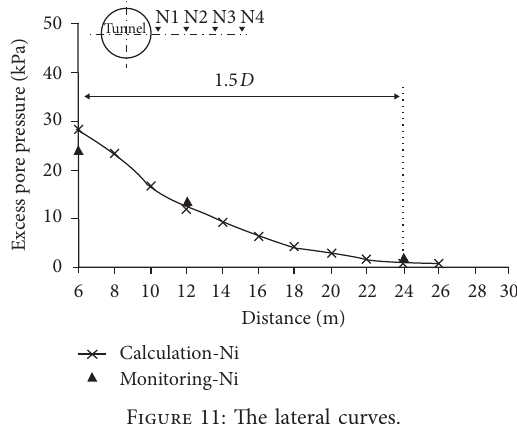
Figure 11: The lateral curves.